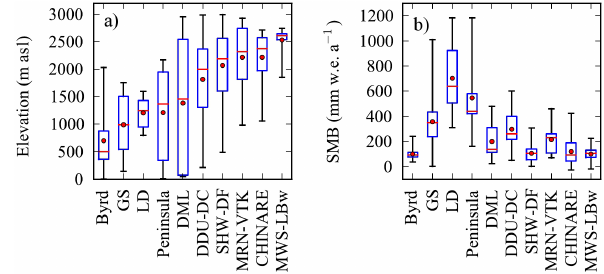
Fig. 6. Boxplot distribution of (a) elevation and (b) SMB values for each selected dataset. Red dots are the mean values. Red lines rep- resent 50% occurrence, the first and third quartiles are represented by the box bounds, and the minimum and maximum values by the black